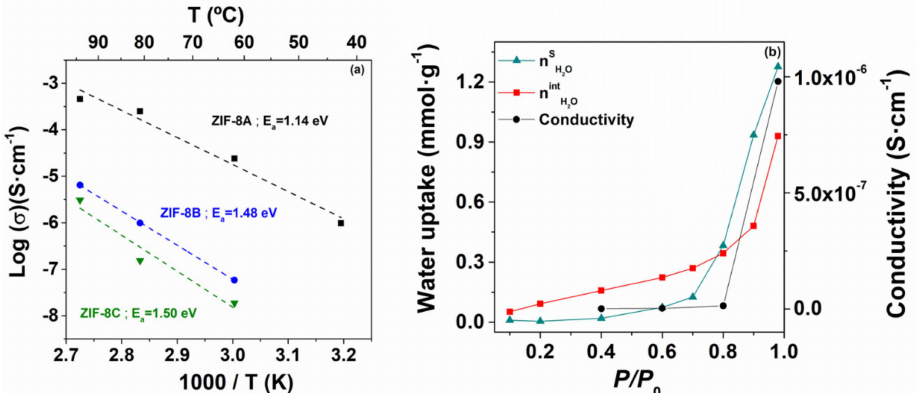
Figure 6. ( a ) Log-scaled protonic conductivity of ZIF-8A (black), ZIF-8B (blue) and ZIF-C (green), plotted as a function of the inverse temperature and measured at 98% relative humidity; ( b ) Conductivity, n S and n int as a function of relative humidity for the nanostructured H 2 O H 2 O